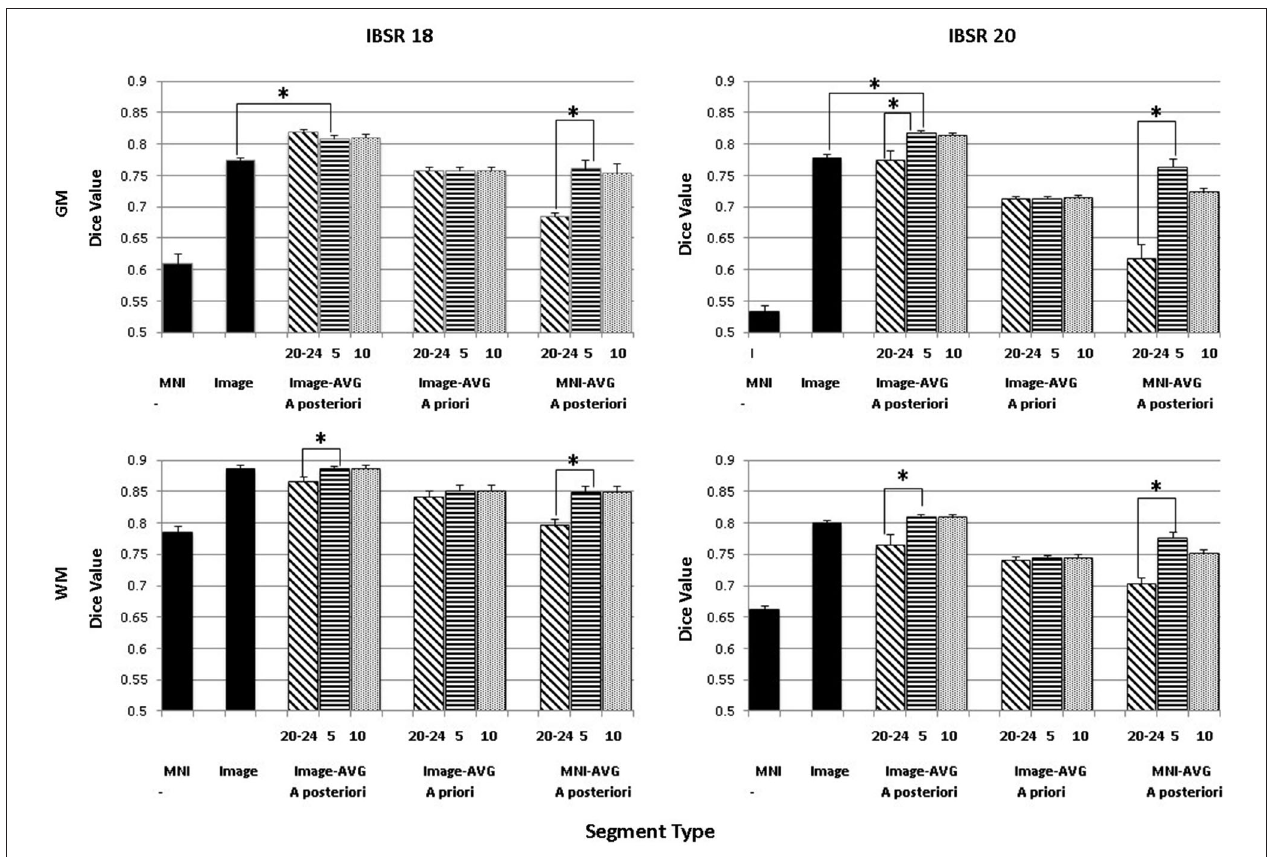
our young adult (“20–24”) template. “MNI” refers to the standard MNI152 priors, and “Image” refers to segmentation from the base image, without explicitly specifying priors. Note that performance is generally best for a posteriori specification, using age-appropriate priors within a five-year range. Selected significant post hoc comparisons are highlighted; the “MNI” template had the lowest Dice values for each